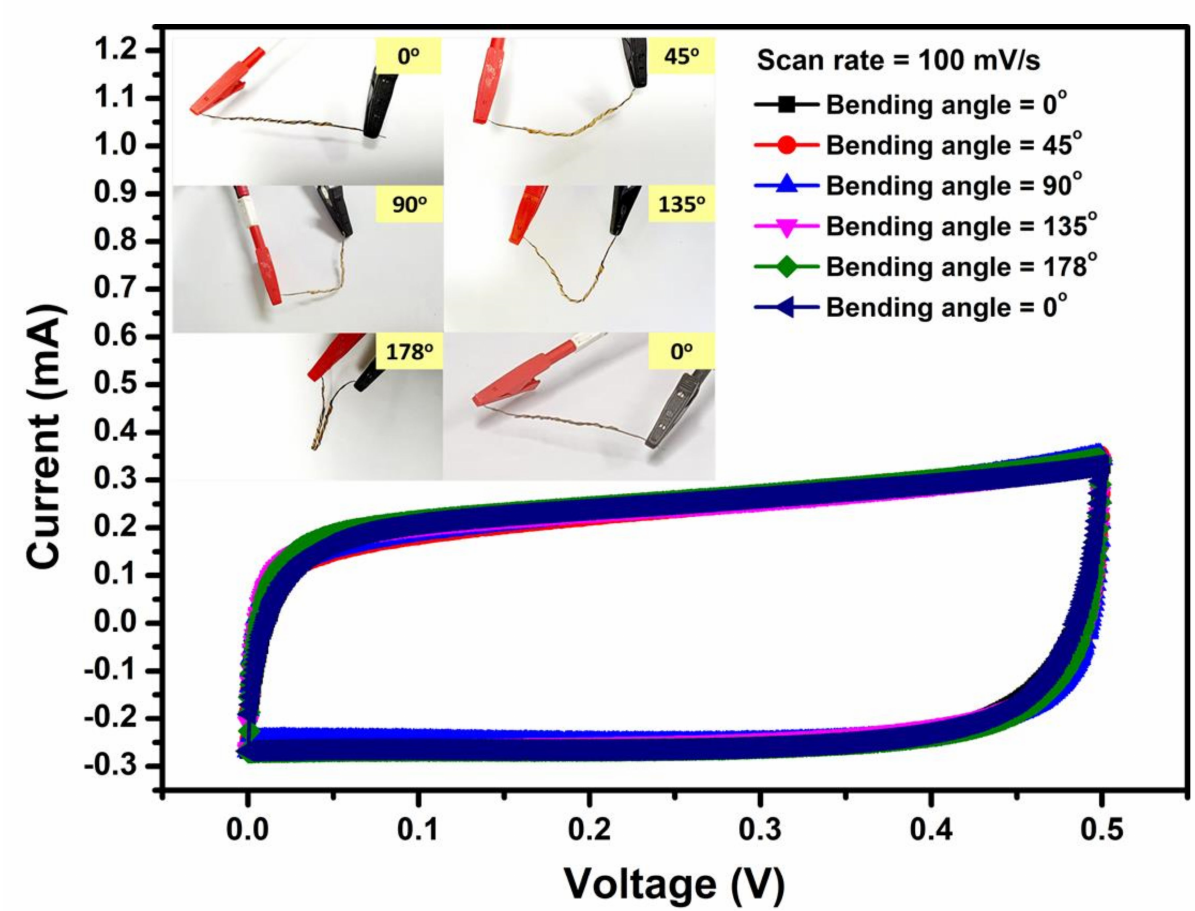
Figure 13. CV curves relating to various bending angles of Ni 10 /NCO/RGO twisted WSC at 100 mV/s scan rate. The inset shows the photographs of the flexible WSC with different bending